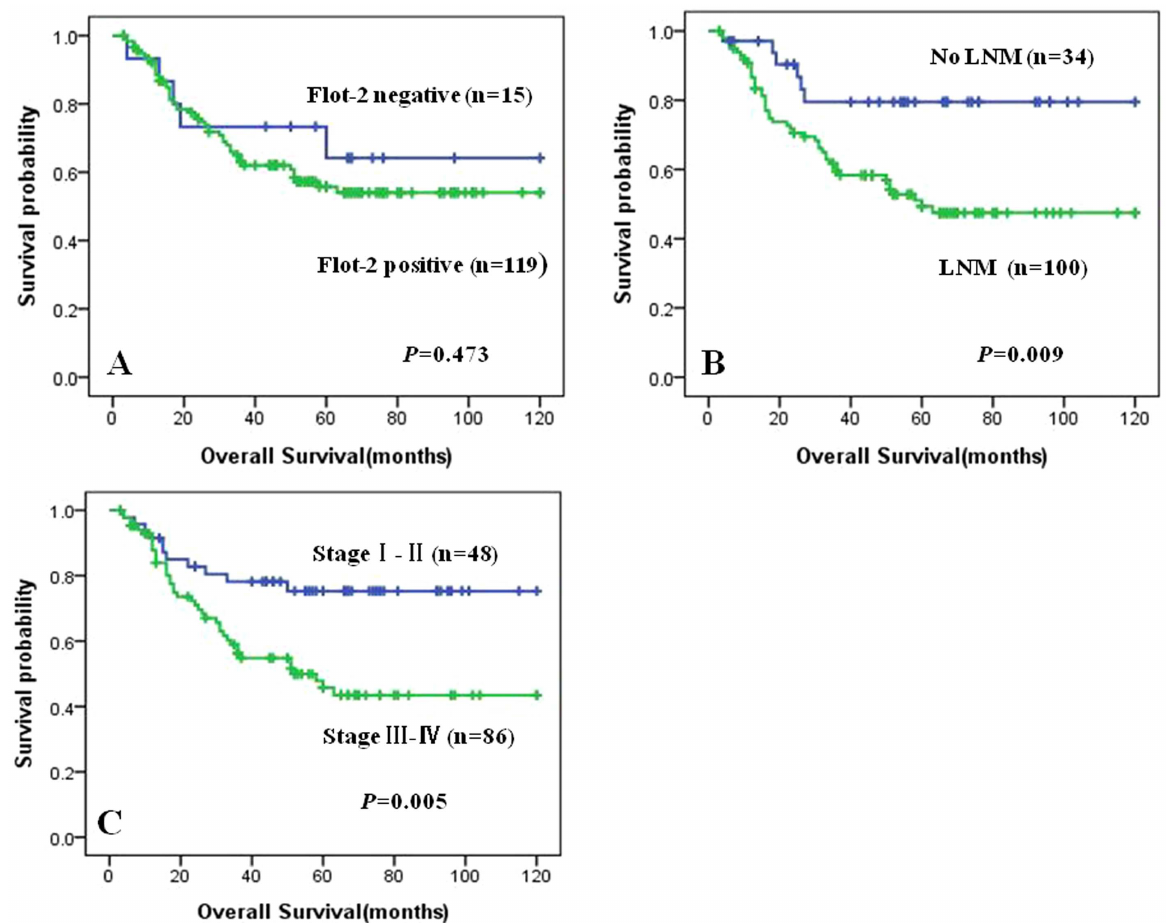
Figure 3. Kaplan-Meier curve for overall survival of NPC patients with expression of Flot-2 and different clinicopathological characteristics. Kaplan-Meier analysis to plot the overall survival curves of all 134 NPC patients with expression of Flot-2 and different clinicopathological characteristics and statistical significance was assessed using the long-rank test. Fig 3A Expression of Flot-2 protein in the NPC patients was no significantly related to their prognosis (P . 0.05, two sided). Fig 3B NPC patients with lymph node metastasis were significantly related to poor prognosis compared to those patients without lymph node metastasis (P=0.009, two sided). Fig 3C NPC patients with clinical stage III-IV were significantly related to poor prognosis compared to those patients with clinical stage I-II (P=0.005, two sided).